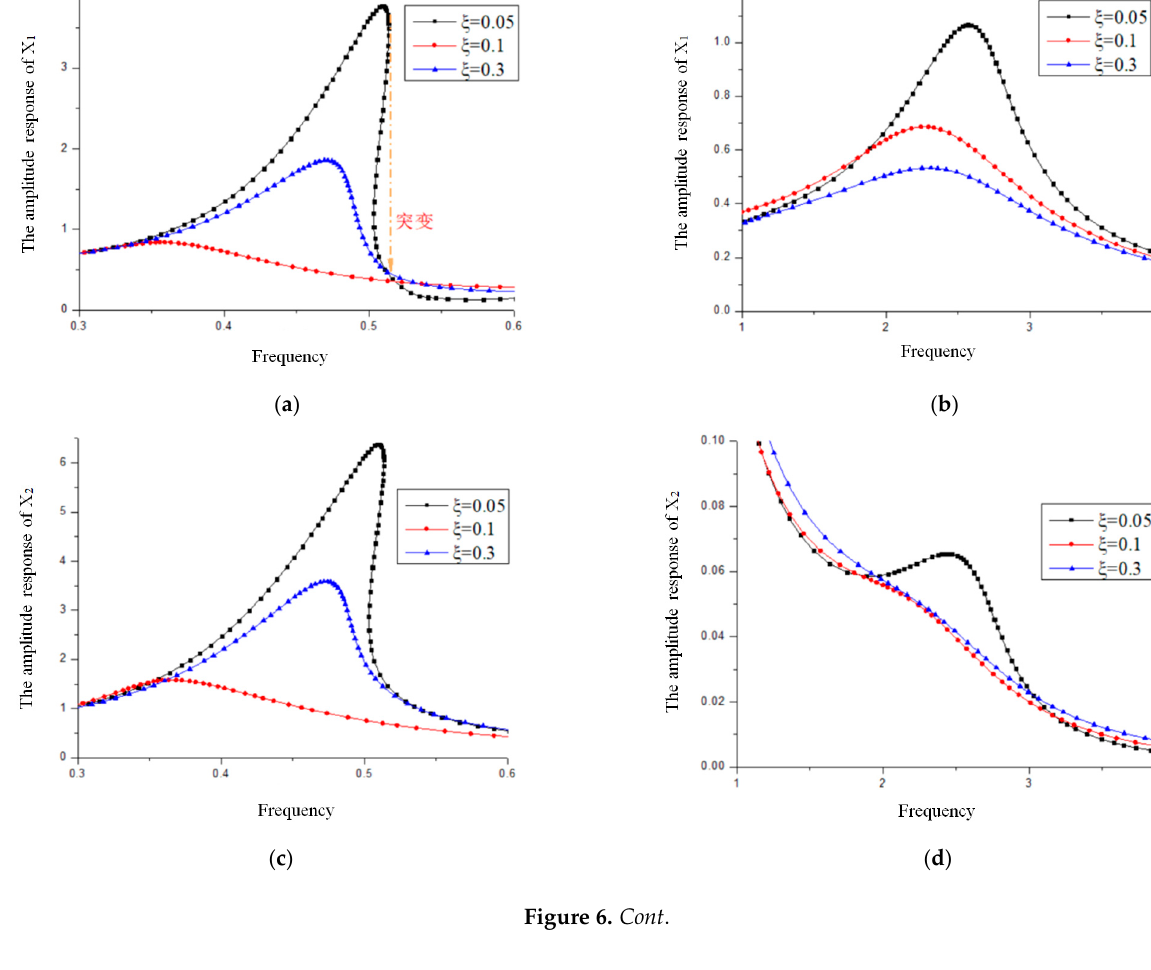
( f ) Figure 6. Amplitude – frequency characteristic curves of the isolation structures with different damping ratios (when ξ = 0.05, 0.10.3, =0.25 0.75